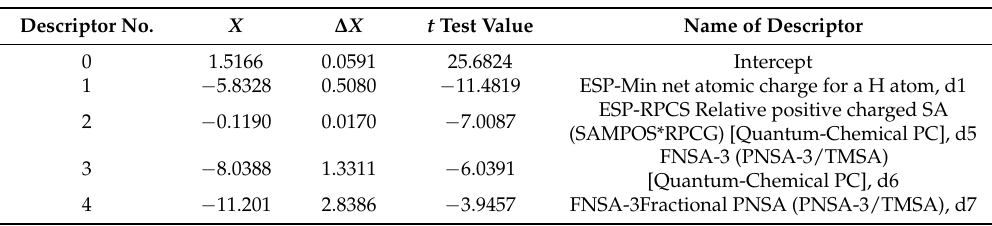
Table 4. Multilinear QSAR model obtained for cinnamaldehyde analogues for Gloeophyllun trabeum ( R 2 = 0.926, F = 43.95, and s 2 = 0.0049).